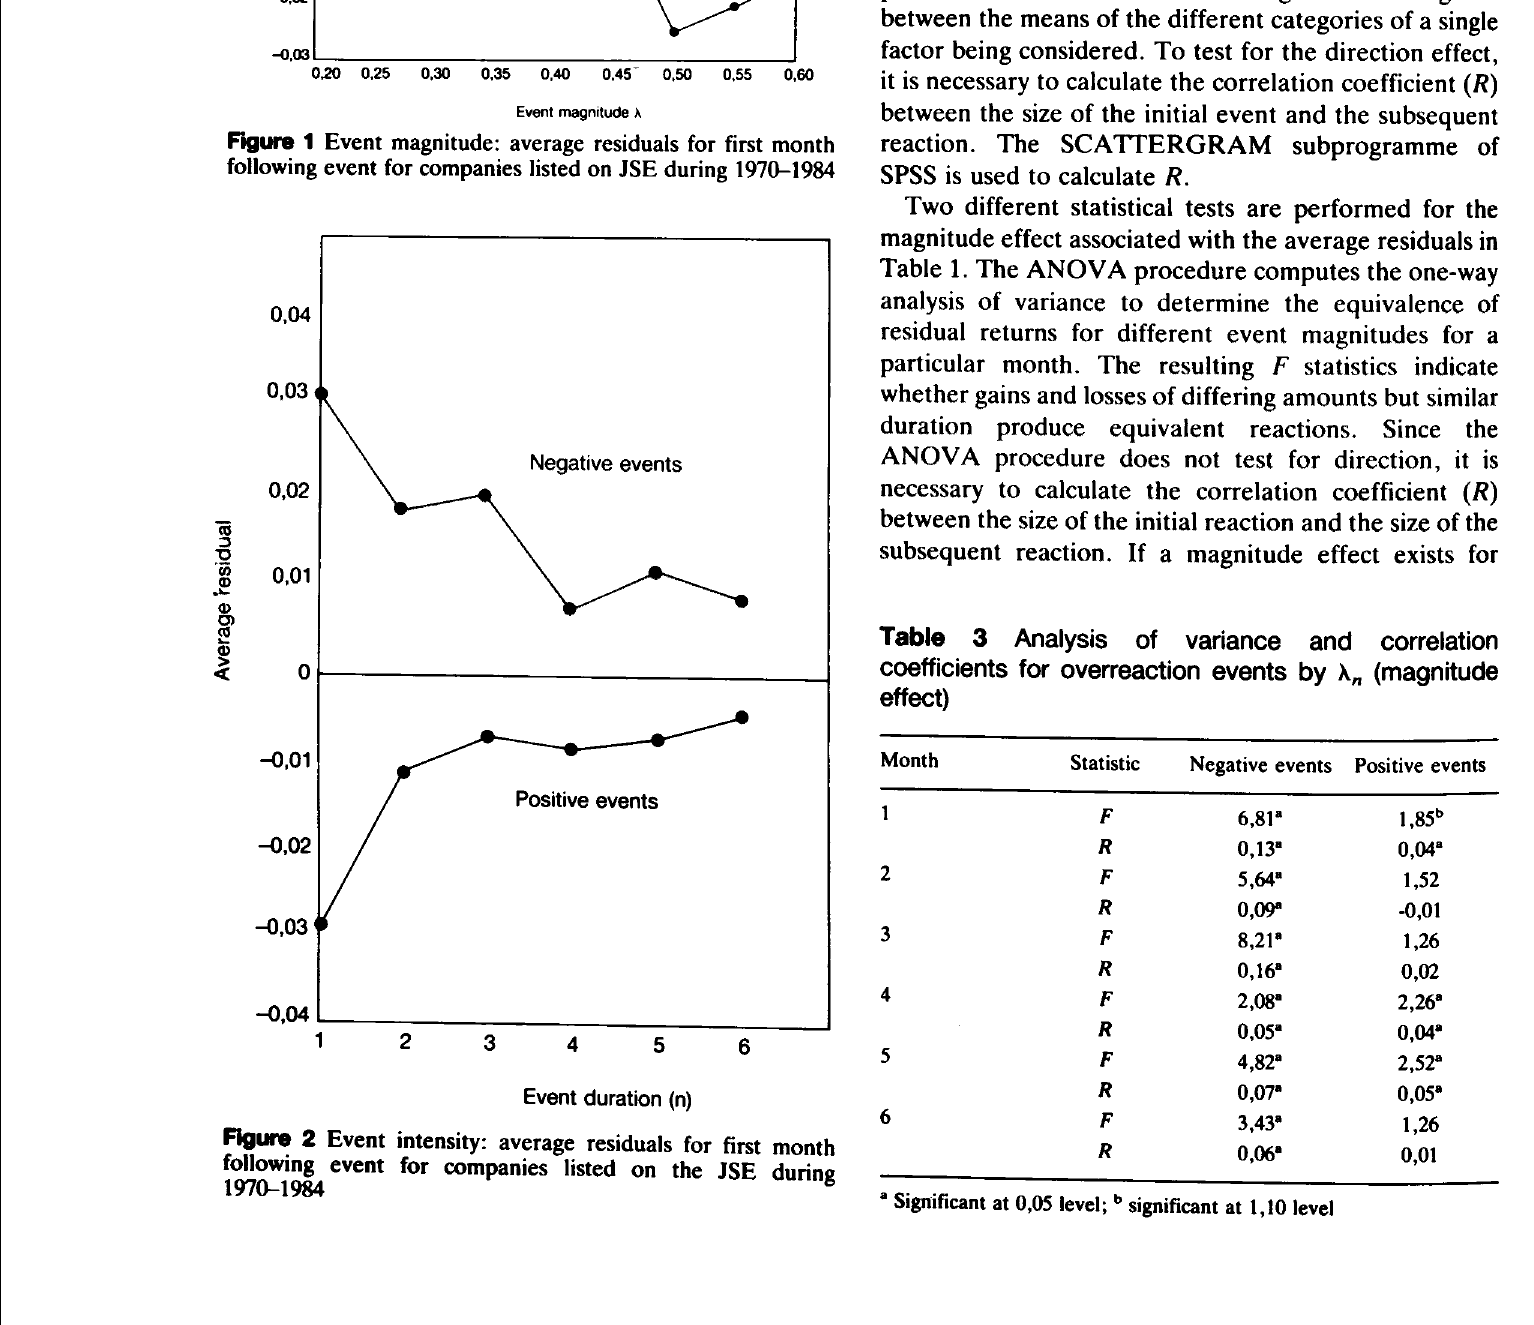
Figure 1 Event magnitude: average residuals for first month following event for companies listed on JSE during 1970--1984